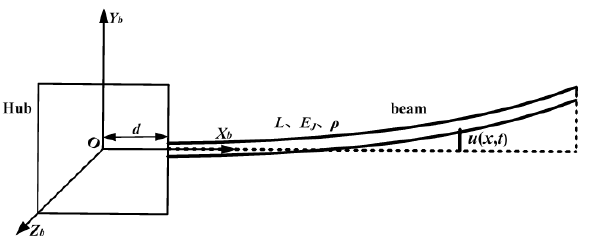
The relative errors are too much at time 42.5 s. But at time 100 s, the relative error has decreased sharply to meet the accuracy requirements of the